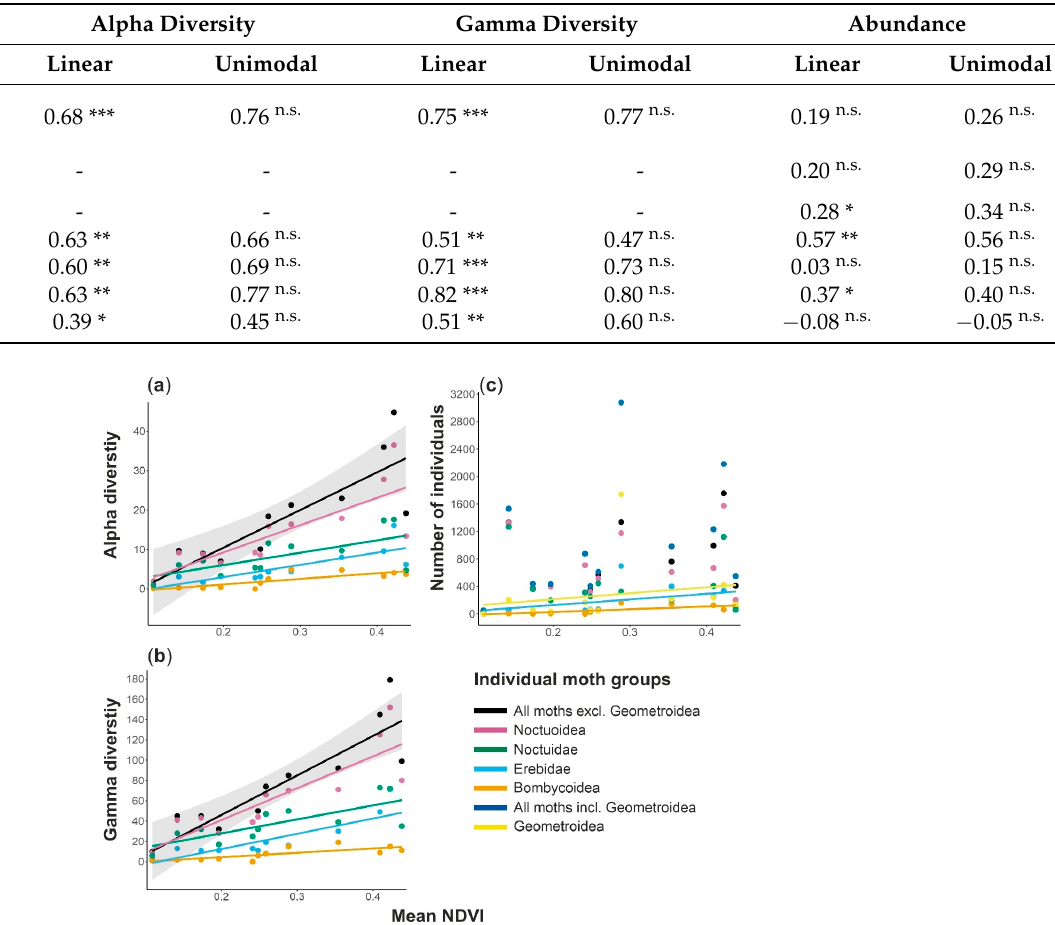
Figure 2. Effects of environmental productivity (mean NDVI) on ( a ) alpha diversity (i.e., mean local species richness), ( b ) gamma diversity (i.e., regional species richness), and ( c ) numbers of individu- als (i.e., abundance) in individual moth groups in southern Africa. Only the significant relationships are visualized; see Table 3 for all models results. Shaded areas indicate 95% confidence intervals for the main models with all target moth groups pooled.